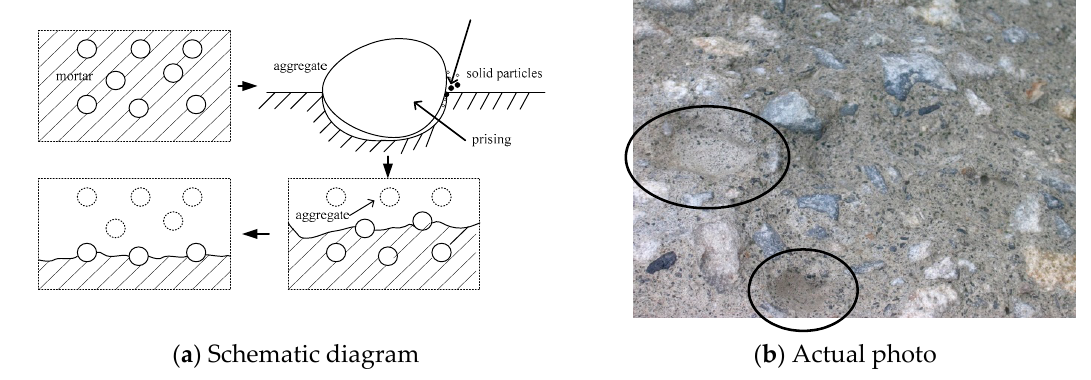
Figure 1. Abrasion process and abrasion damage of hydraulic concrete surface.